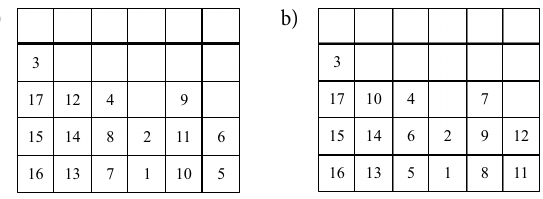
Fig. 7. The loading sequences based on two different rules: a – actual scheduling rules; b – improved heuristic